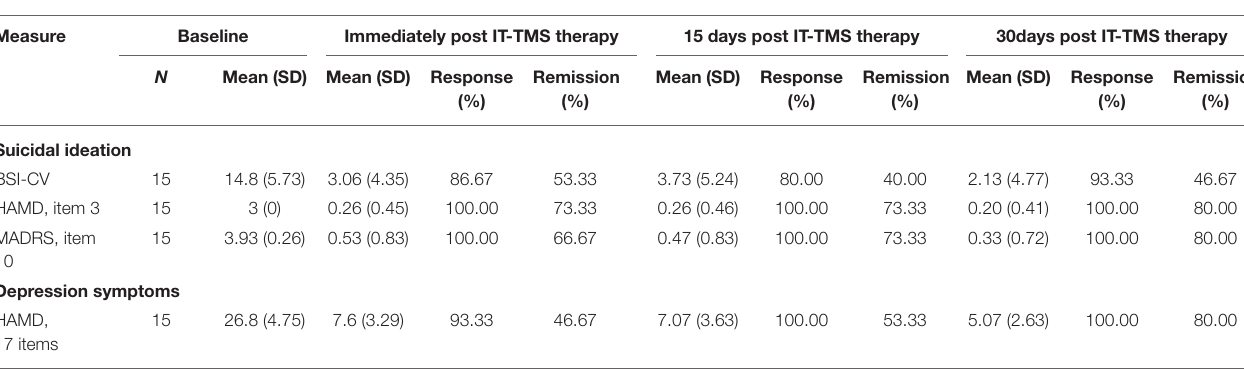
TABLE 1 | Clinical assessment score for patients a